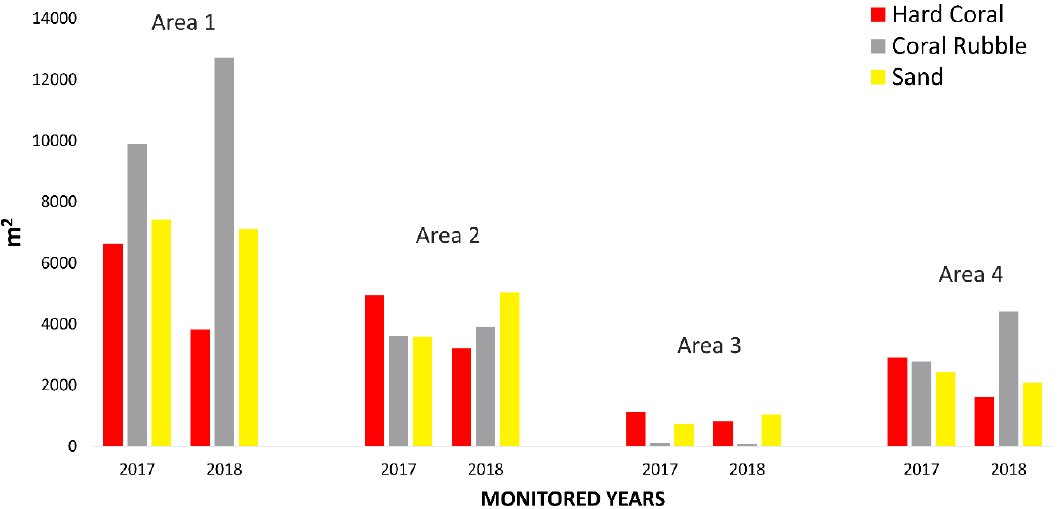
Figure 5. The extent of detected substrates in the monitored areas between years.